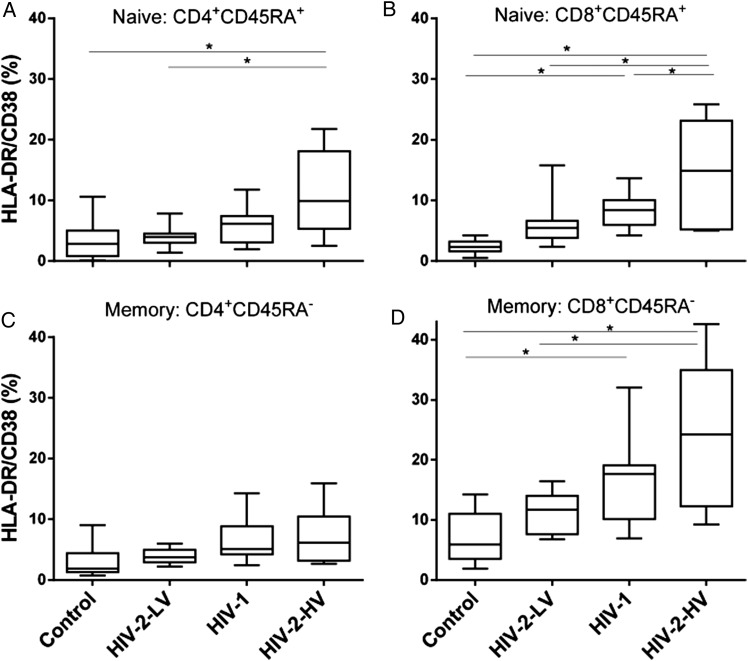
HIV-1 and HIV-2 at high viral loads induce immune activation in both naive and memory T-cell subsets. Values represent proportion of T-cells coexpressing HLA-DR and CD38, as median, interquartile (box) and range (whiskers) within the following populations: (A) CD4+CD45RA+ and (B) CD8+CD45RA+ “naive” cells; (C) CD4+CD45RA− and (D) CD8+CD45RA− “memory” cells. HIV-2-LV and HIV-2-HV refer to low and high viral load HIV-2-infected subjects. Group differences tested by ANOVA: (A) 0.012, (B) <0.001, (C) 0.059, (D) <0.001; *P < .05 by post hoc (Tukey) test. Hierarchical trend analysis across groups ranked in this order, P < .01 for all cell types. No differences were observed between memory and naive CD4+ T-cells, median values, all subjects, CD45RA+ 4.51% versus CD45RA− 4.30% (P = .554), but in CD8+ cells, activation was greater in memory cells, median CD45RA+: 5.72 versus CD45RA−: 12.8% (P < .0001, Wilcoxon matched-pairs signed rank test). Abbreviations: ANOVA, analysis of variance; HIV, human immunodeficiency virus; HIV-2-HV, HIV-2 infected with high viral load (>1000 copies/mL); HIV-2-LV, HIV-2 infected with low viral load (<100 copies/mL); HLA, human leukocyte antigen.